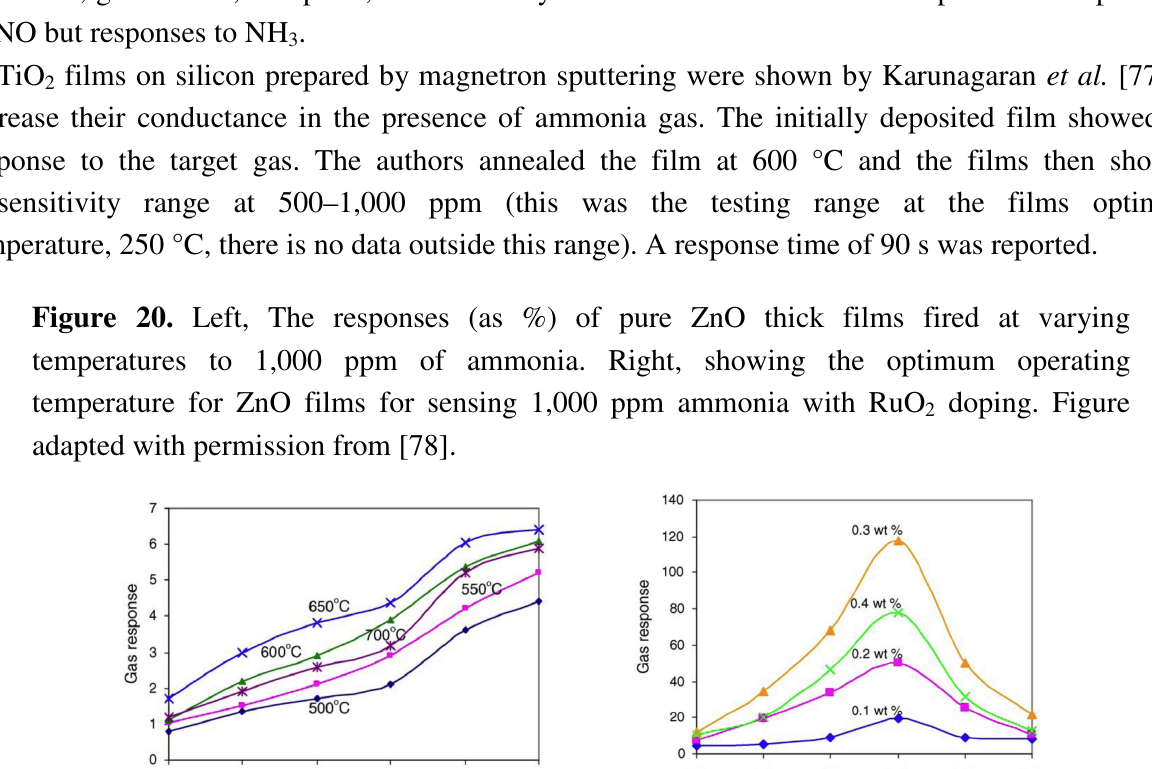
doping. Figure 2